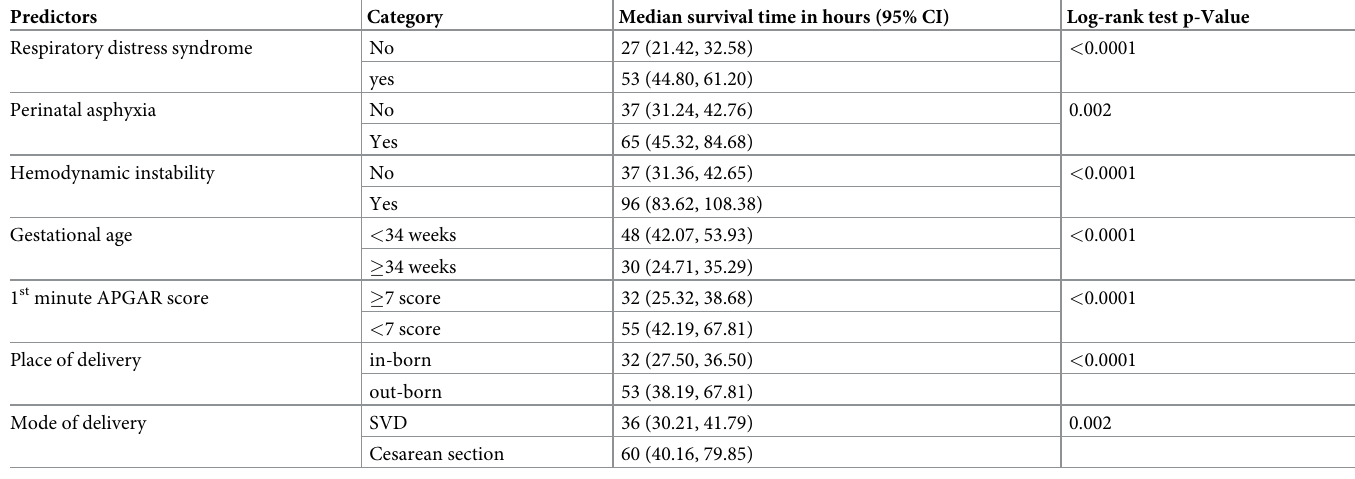
Table 4. The group-specific median time of starting TF among neonates admitted in NICU of DMCSH, FHCSH, and TGCSH, Amhara, Northwest Ethiopia from October to November /2020 (n = 210).